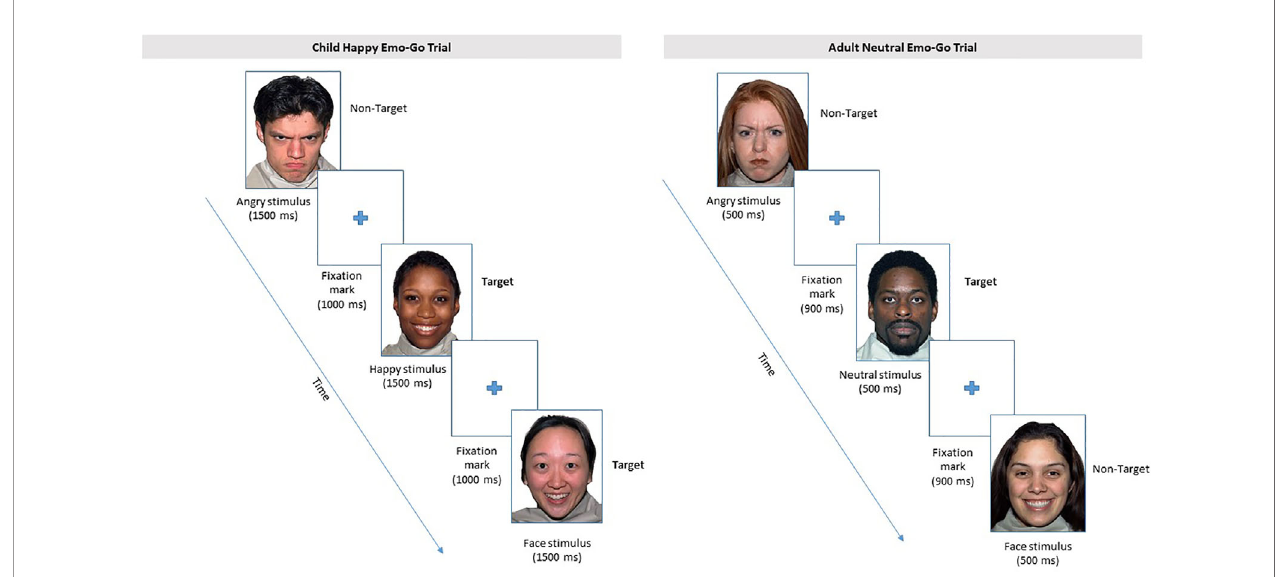
FIGURE 7 | From the Emotional Go/No-Go task, depictions of the “ happy ” block for children, and of the “ neutral ” block for parents are presented. Other emotion blocks follow a similar schema for children and adults, respectively. Participants are instructed to respond with a button press to the target emotion of each block and withhold a response for all other emotions in that block. Face stimuli were selected from the MacBrain Face Stimulus set available at